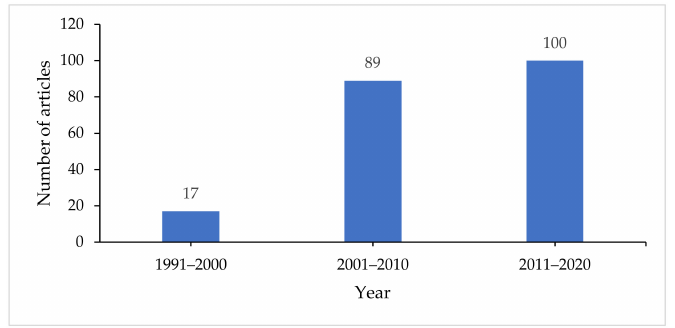
Figure 1. Documents published from 1991 to 2020 grouped into